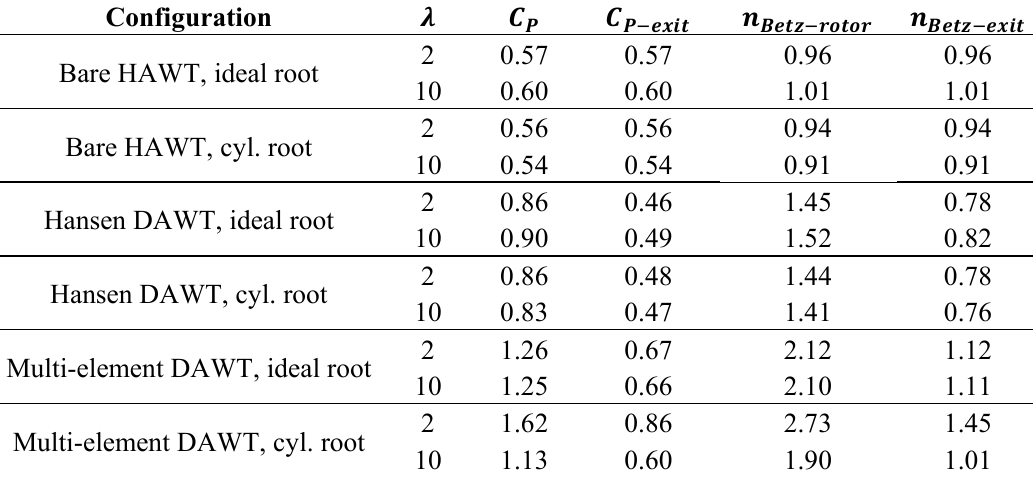
Table 3. Summary of power-optimal performance results ( (cid:1838) (cid:1830)⁄ (cid:3404) ∞ ).